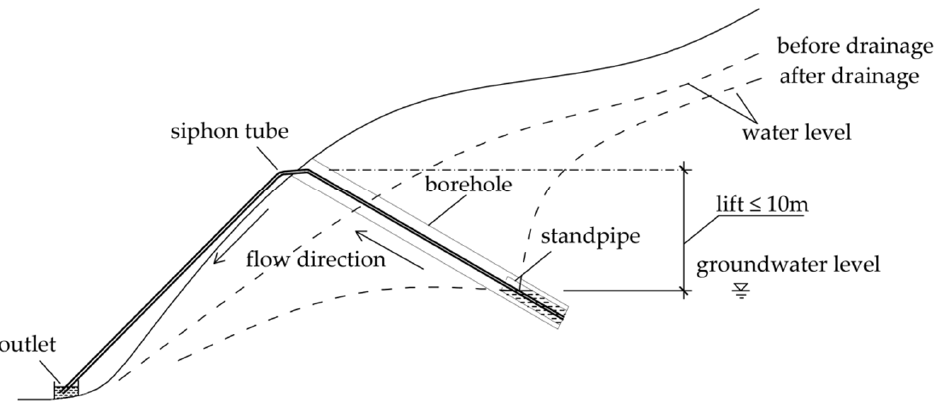
Figure 1. Schematic diagram of the inclined pipe-siphon drainage method.